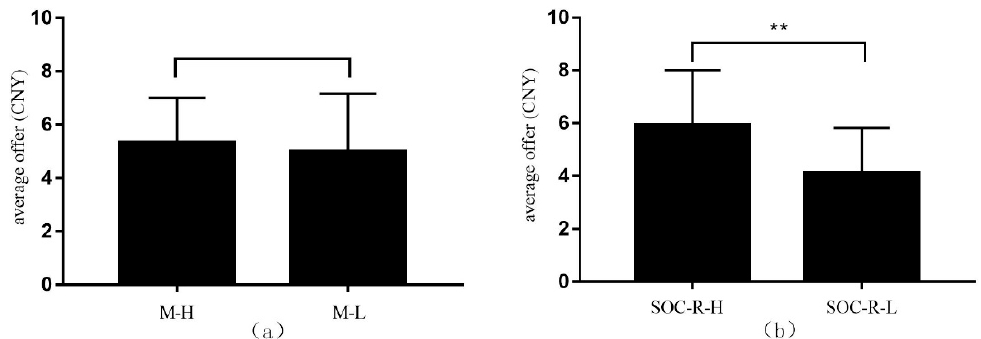
Figure 3. The differences in the average offer on money motivation and sense of community responsibility (SOC-R). ( a ) Test of difference in altruism level between high and low money motivation groups; ( b ) Test of difference in altruism level between high and low SOC-R groups. Note: M-H = group with high money motivation, M-L = group with low money motivation; SOC-R-H = group with a high level of sense of community responsibility, SOC-R-L = group with a low level of sense of community responsibility (** p < 0.01).